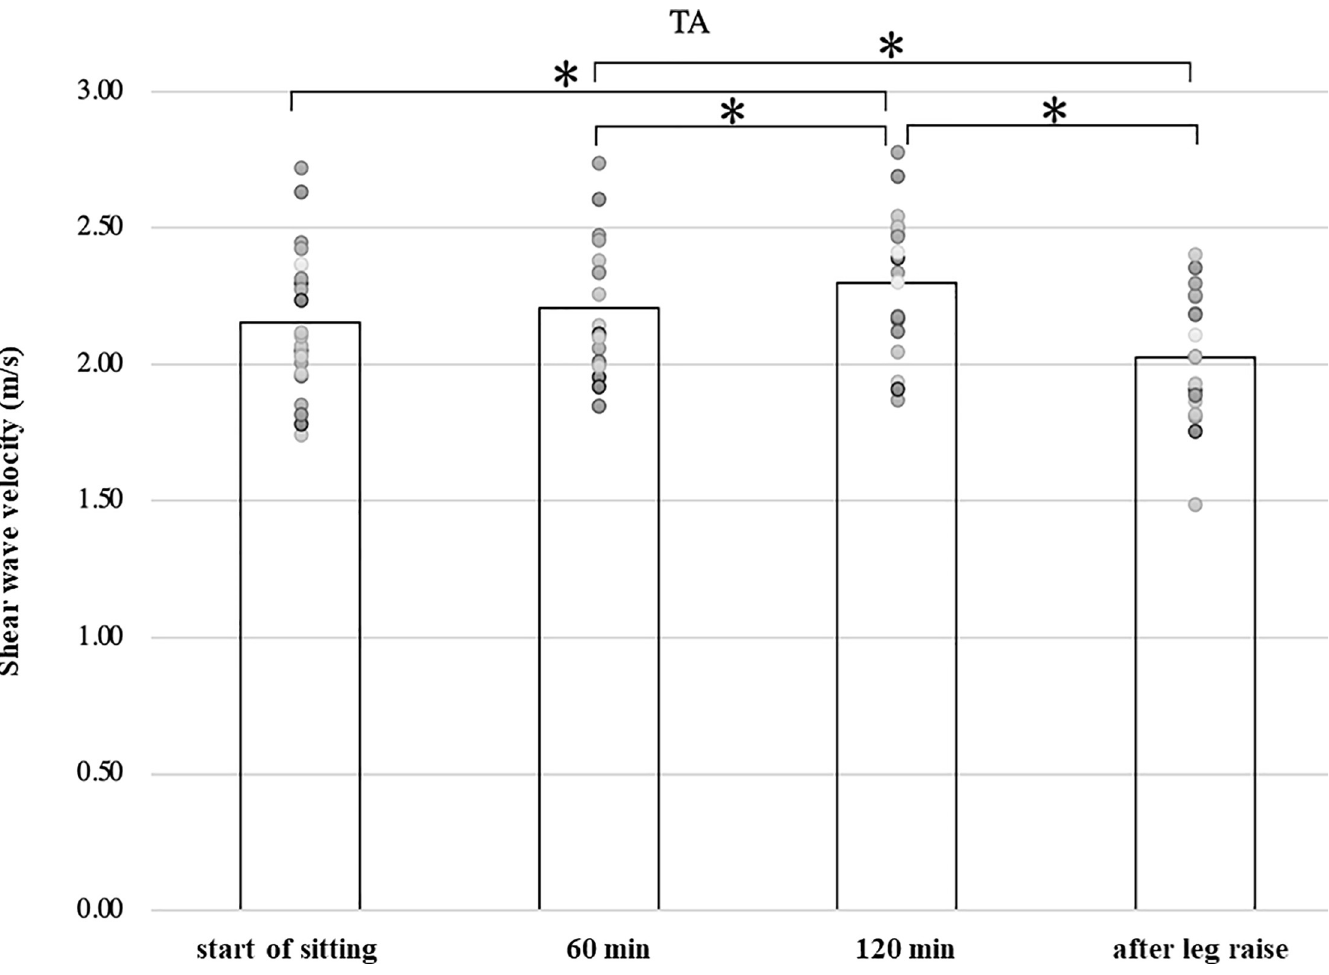
Fig 8. Shear wave velocity of the tibialis anterior muscle.